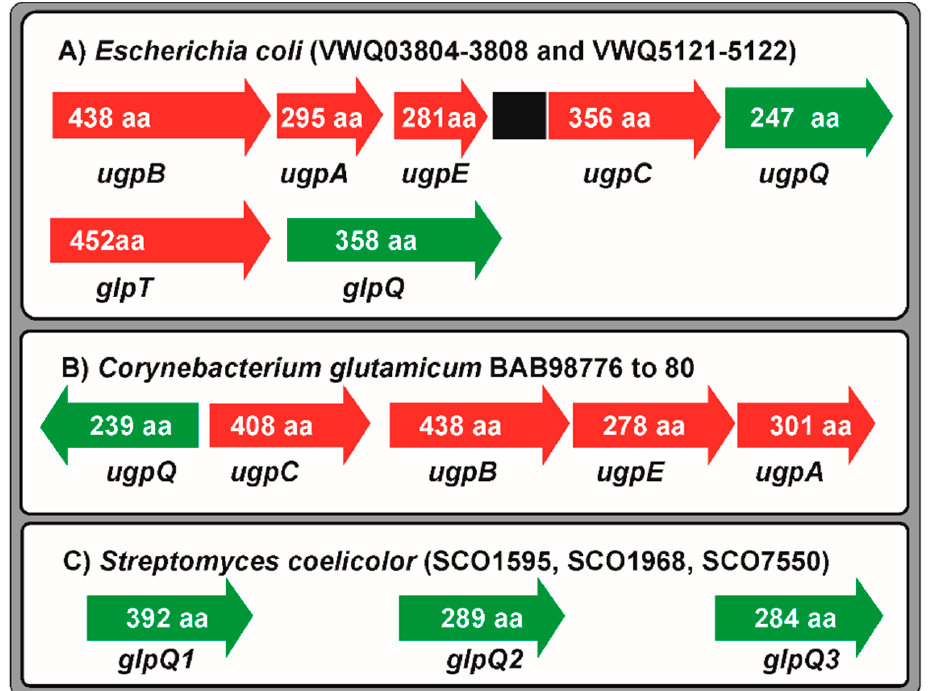
Figure 3. Gene clusters for glycerol-3-phosphate and phosphodiesters uptake in E. coli and Actinobacteria. ( A ) Cluster ugpBAECQ and glpQT in E. coli. ( B ) Cluster upgQABE in C. glutamicum . ( C ) The non-clustered extracellular glycerophosphodiester phosphodiesterases of S. coelicolor . Note that Streptomyces species lack the ugp cluster. The accession number of the genes and the number of amino acids is indicated. Transporter genes are shown in red. Glycerophosphodiester phosphodiesterases genes are shown in green. Genes not related with glycerol- 3 -P or phosphodiesters uptake are indicated in black.